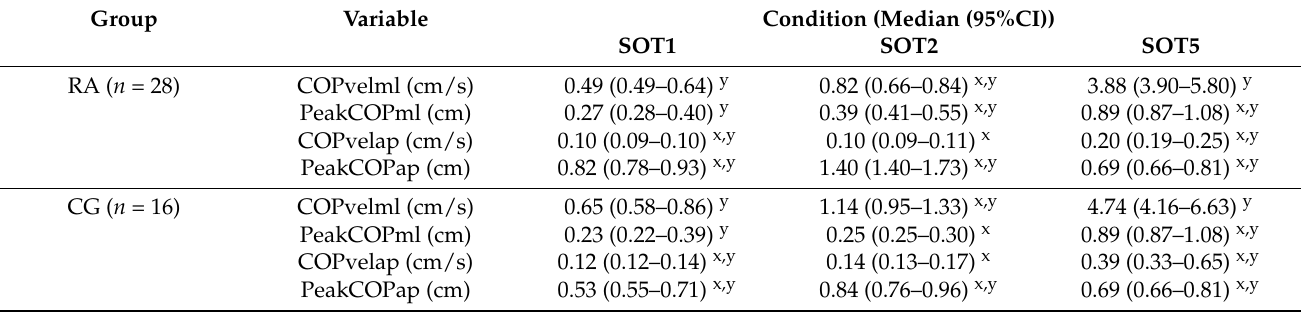
Table 4. Effect of the groups (RA or CG) and of the SOT conditions on the biomechanical